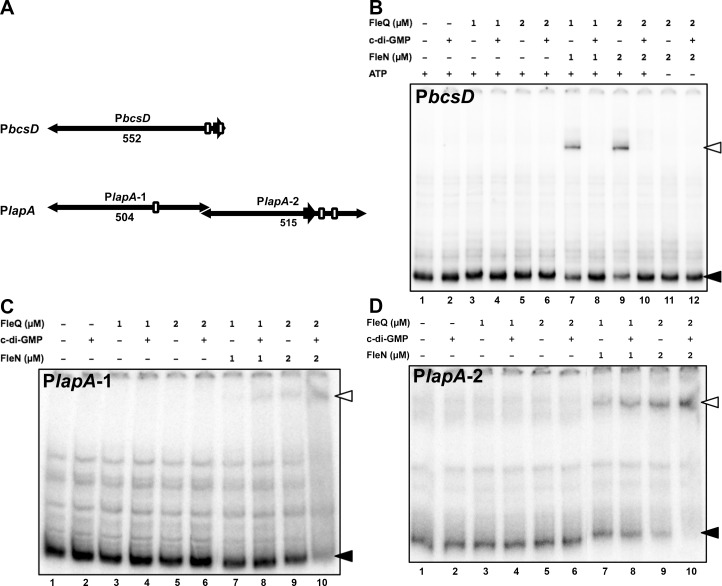
Gel mobility shift assays on the PlapA and PbcsD promoters.Panel A: Cartoon of the probes used for each of the promoter regions, indicating the sizes (in bp) of the resulting fragments and the location of the predicted FleQ binding motifs (open boxes). Drawn to scale. Panels B, C and D: Autoradiograph of a representative PAGE gel containing the indicated probe, 0, 1 or 2 μM FleQ and 0, 1 or 2 μM FleN. Assays were performed in the absence (-) or in the presence (+) of c-di-GMP and in the absence (-) or in the presence (+) of ATP. Closed arrowheads denote the free DNA probes and open arrowheads denote the retarded complexes.